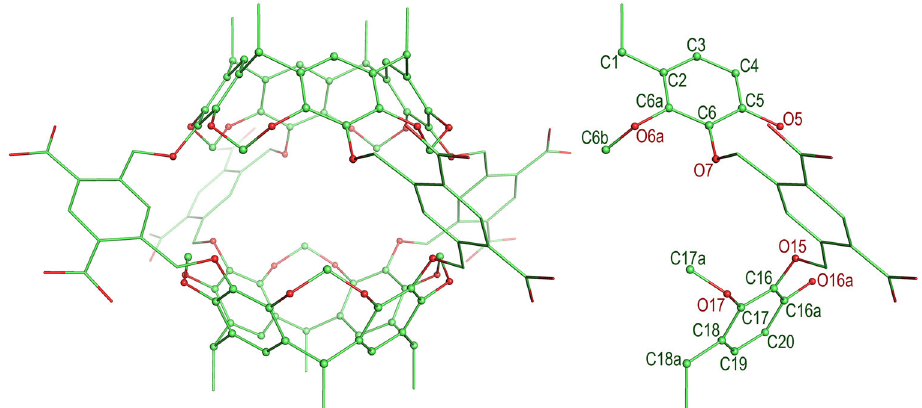
Fig. 4 The atoms that con fi ne the Octacid4 cavity. All atoms that con fi ne the cavity are shown with the sphere model. The names of the atoms in the HC1 residue that con fi ne the cavity are C1, C2, C3, C4, C5, C6, C6a, O5, O6a, O7, C6b, C18a, C16, C17, C18, C19, C20, C16a, O15, O16a, O17, and